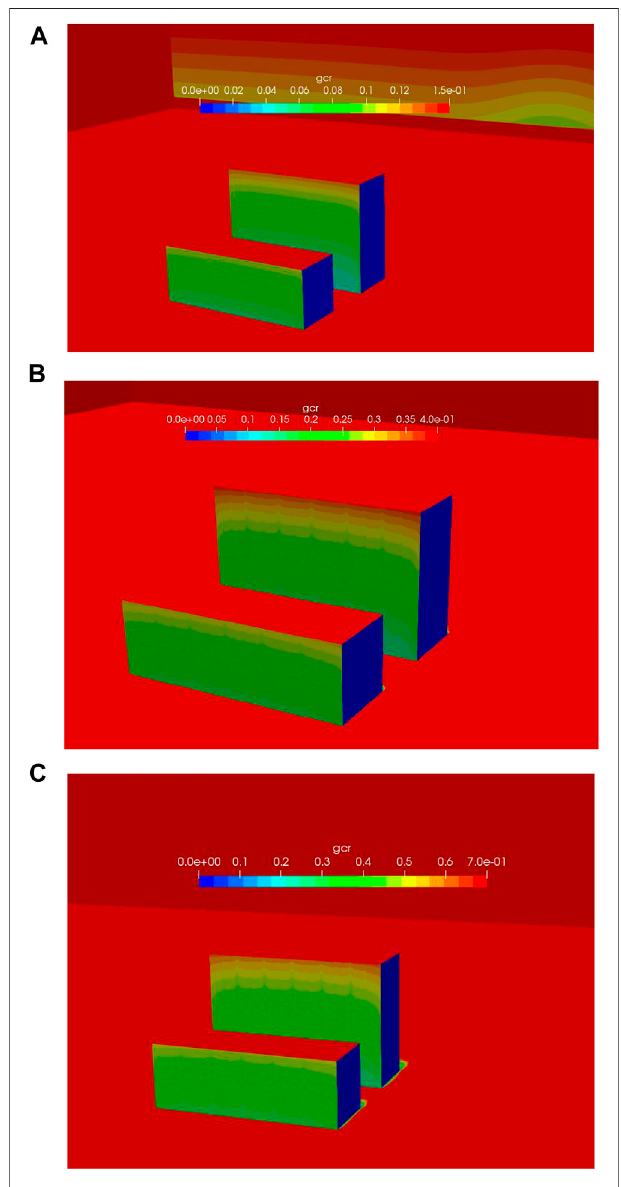
FIGURE 3 | Catch ratio distribution of building facades at different reference velocities: (A) U ref (cid:2) 1m/s, (B) U ref (cid:2) 3m/s, and (C) U ref (cid:2) 5m/s.